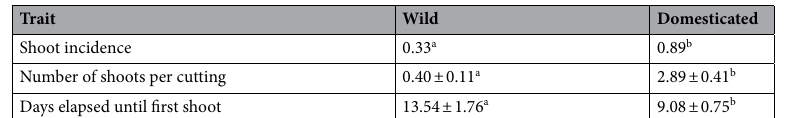
Table 1. Shoot incidence, number (count) and time (days) elapsed after the first shoot was observed in stem cuttings of wild (Wild) and domesticated (Domesticated) chaya ( Cnidoscolus aconitifolius ). Stems were kept under controlled environmental conditions (26 °C, 12 h light/dark) and had no external source of water or nutrients. Data are the mean ± 1 standard error, except for shoot incidence, for which the proportion of cuttings with at least one shoot at the end of the experiment is shown. Different superscript letters indicate statistically significant differences between the cuttings of wild and domesticated plants.